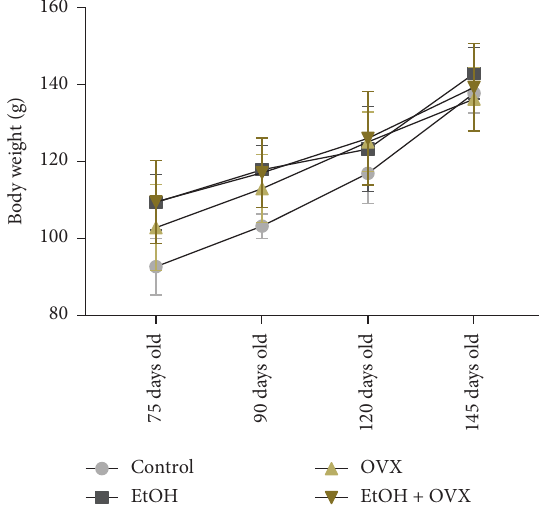
Figure 2: Effects of chronic administration of ethanol (during 55 days) and ovariectomy on the body weight of female Wistar rats ( n � 10 per group). Results are expressed as mean ± standard error of mean. Two-way ANOVA and Tukey’s post hoc test, p < 0 . 05. Ethanol chronic exposure and/or OVX procedure increase/s al- veolar bone